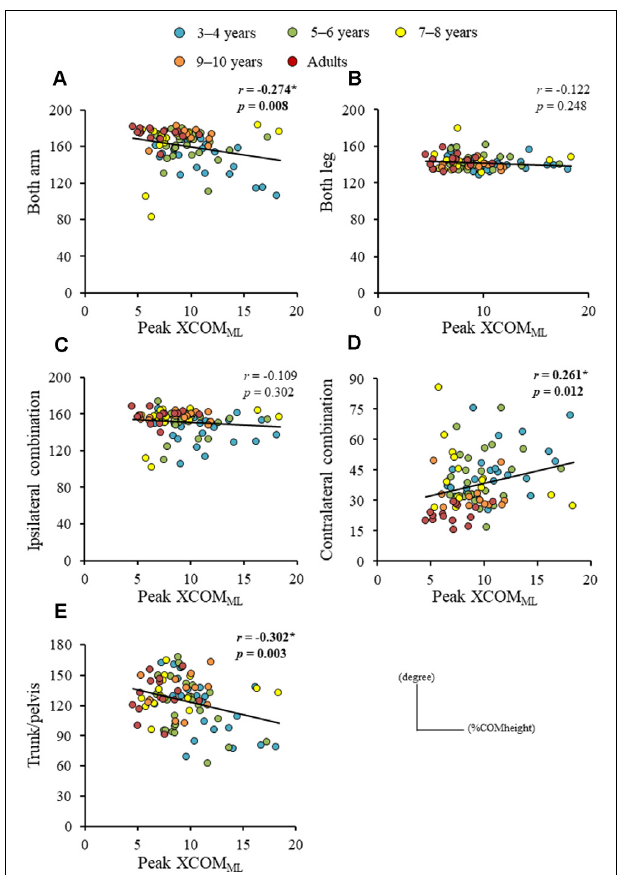
FIGURE 7 | Relationships between peak extrapolated center of body mass (XCOM) displacements in mediolateral axis (XCOM ML ) and (A) mean relative phase (MRP) of both arm combination, (B) MRP of both leg combination, (C) MRP of ipsilateral arm and leg combination, (D) MRP of contralateral arm and leg combination, and (E) MRP of trunk/pelvis combination. *,Significant correlation, p < 0.05.